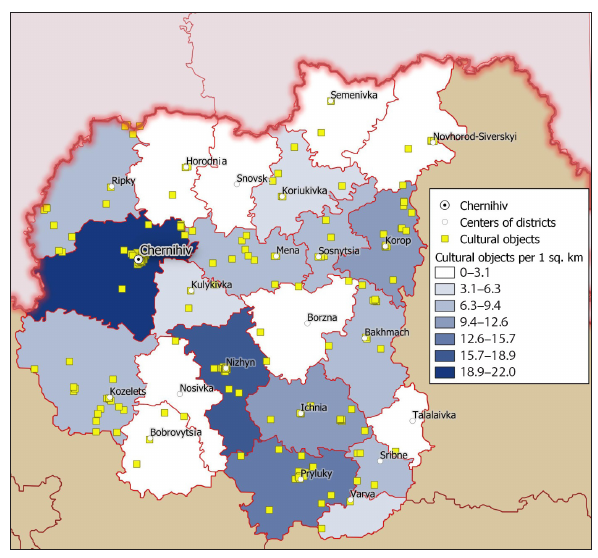
Figure 5. A cartogram showing the number of historical and cultural objects relatively to the area of the